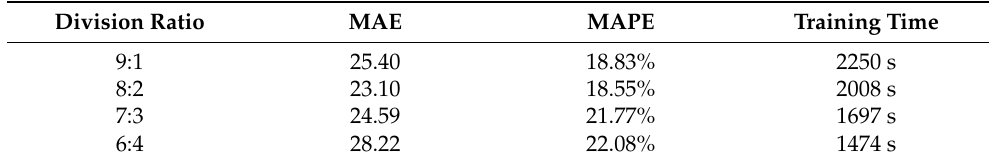
Table 1. Evaluation of model performance with different data division ratio with lstmunits set to 64 and epochs set to 20.